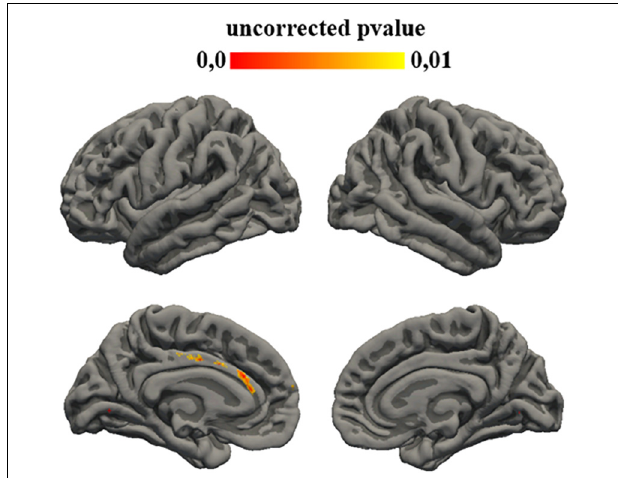
FIGURE 3 | Uncorrected p -value maps for gyrification ADI-repetitive behavior correlation. Significance was set at 0.01.